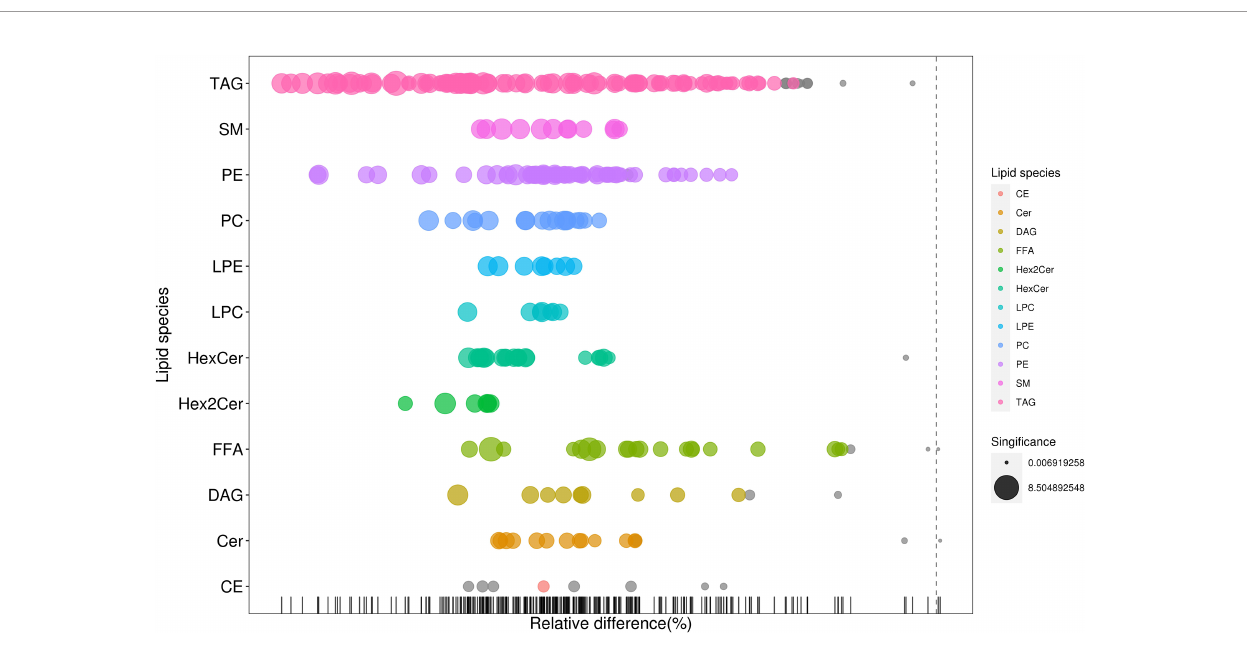
FIGURE 5 | Bubble plot for the treatment (KS) vs control (HC)